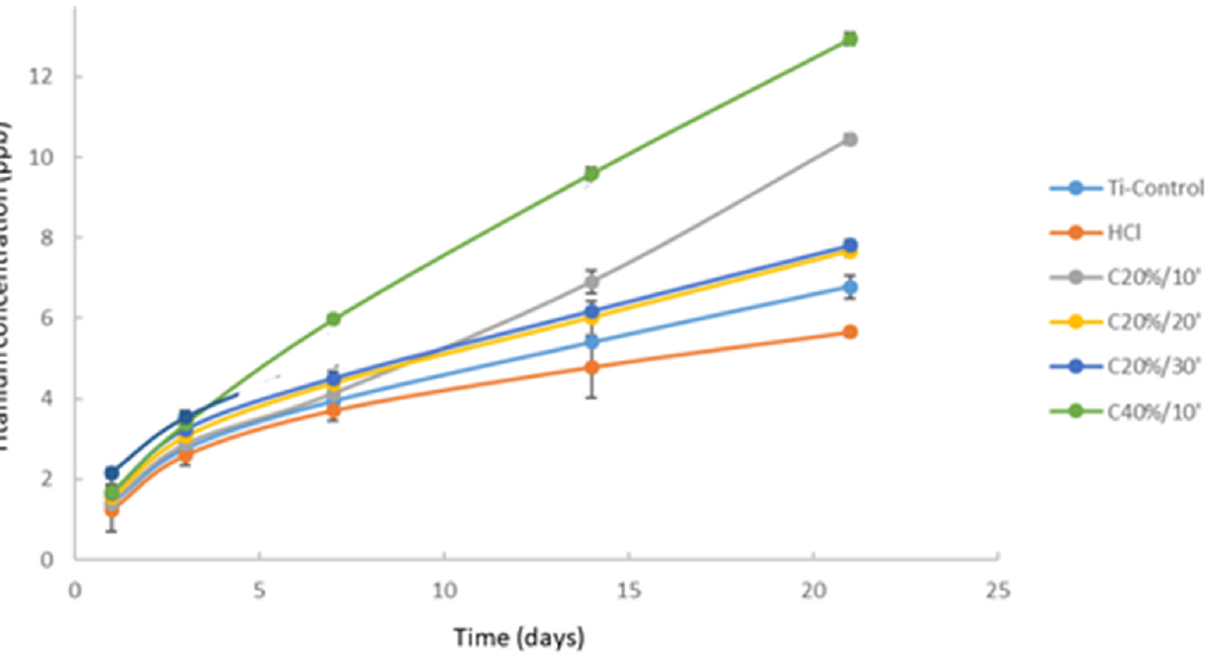
Figure 5. Ion release at different immersion times in Hank’s solution of different passivation treatments on c.p.-Ti.